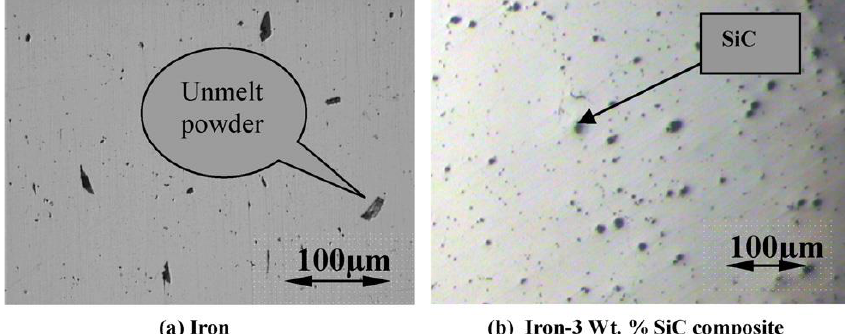
Figure 9. ( a and b ) SEM of iron and iron – SiC composites (sintered at laser speed of 100 mm/s). Reproduced from [53], with permission from Elsevier, 2009.